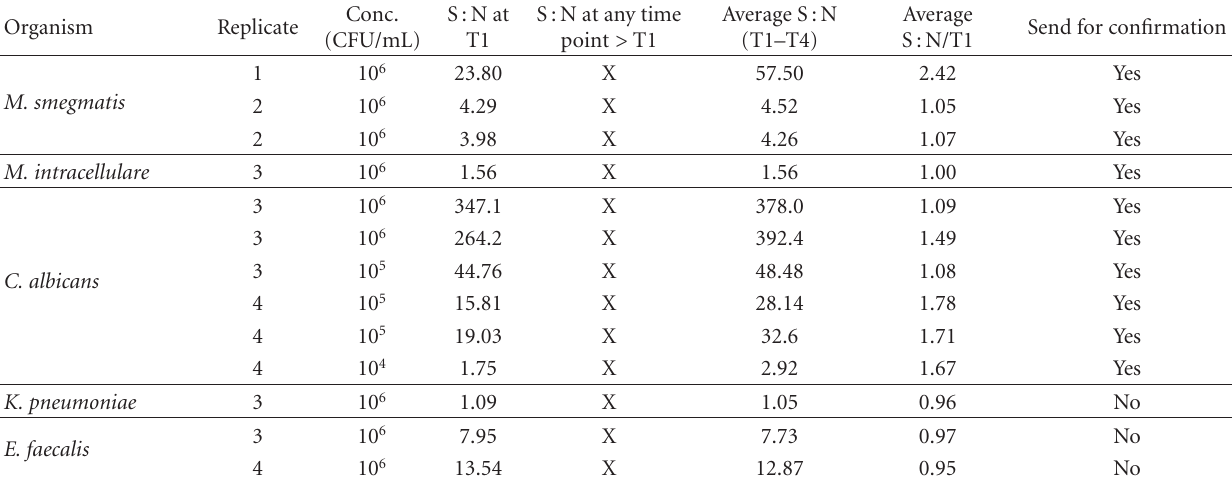
Table 2: Summary results for false positives in the blinded assays.